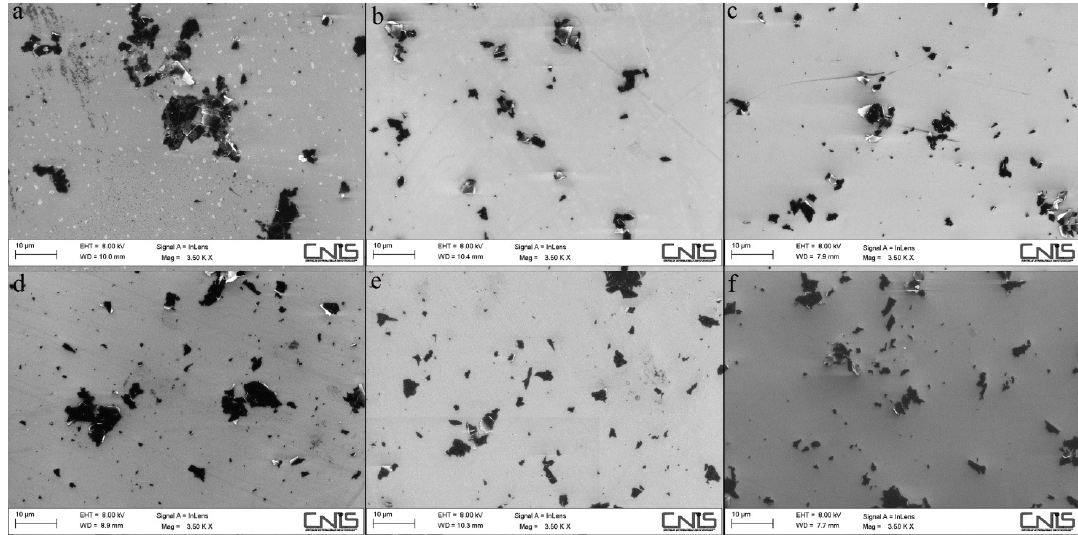
Figure 1. FE-SEM images of the size ( µ m2) of the GNPs in the six di ff erent groups: ( a ) GNPs 1050 ◦ / 1 , ( b ) GNPs 1050 ◦ / 2 , ( c ) GNPs 1050 ◦ / 3 , ( d ) GNPs 1150 ◦ / 1 , ( e ) GNPs 1150 ◦ / 2 , ( f ) GNPs 1150 ◦ / 3.